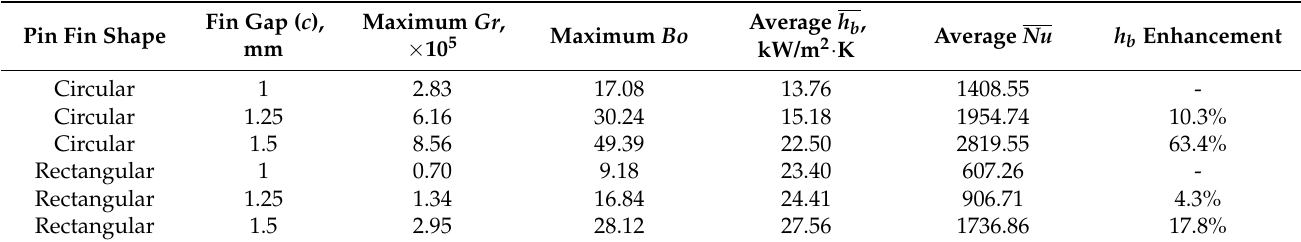
Table 3. Summary of boiling heat transfer performance in various test samples from the